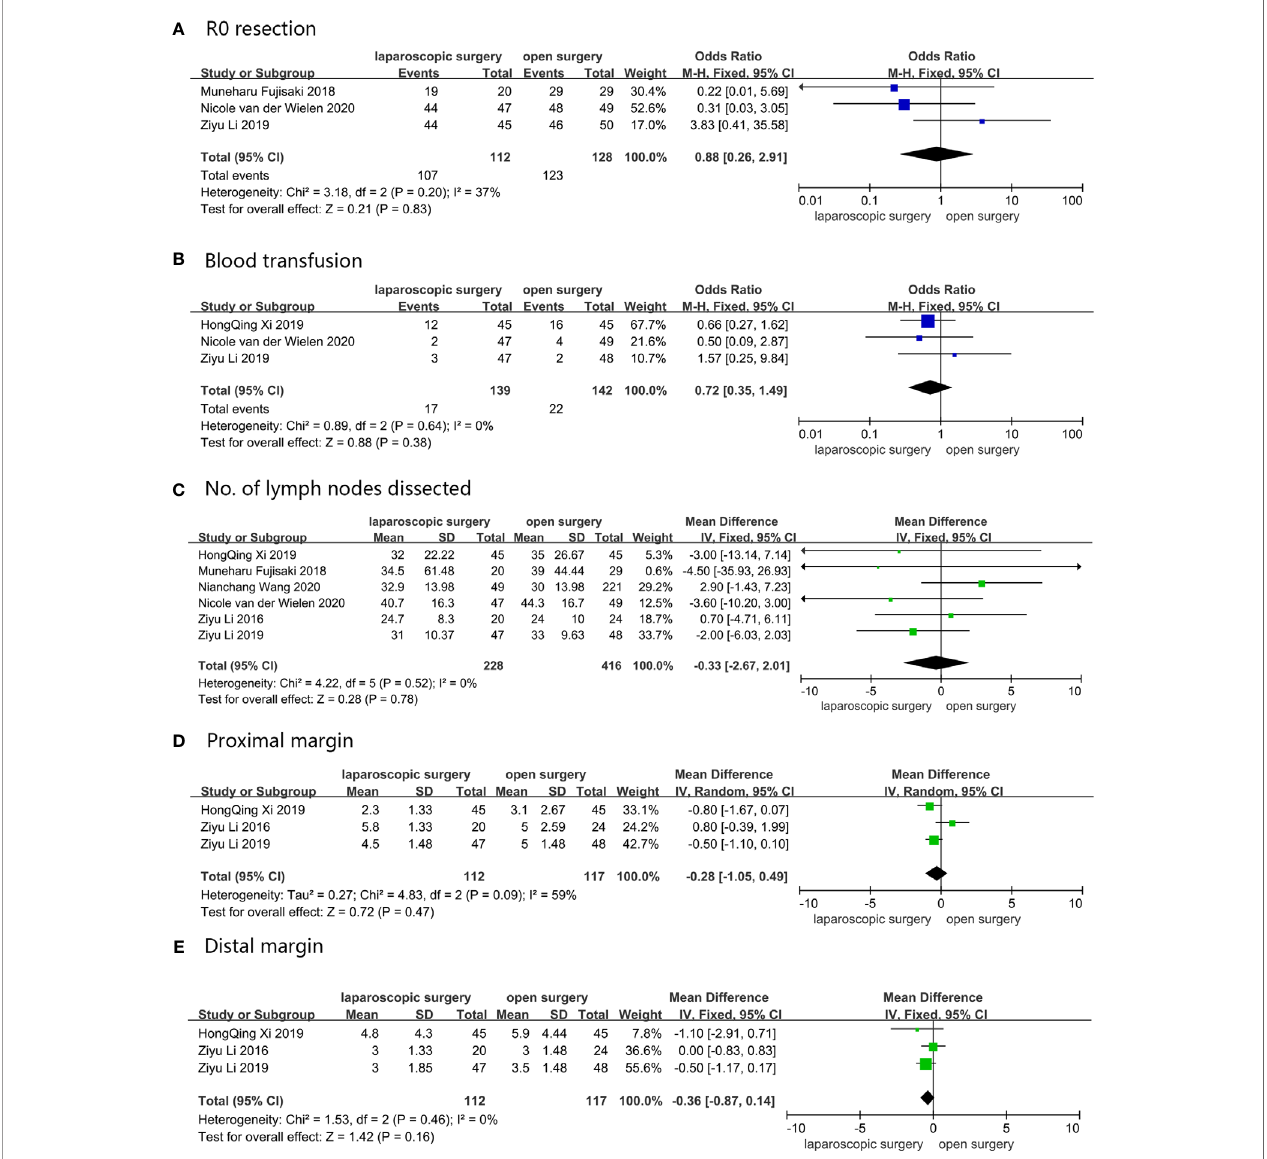
FIGURE 2 | Intraoperative conditions: (A) R0 resection; (B) Blood transfusion; (C) No. of lymph nodes dissected; (D) Proximal margin; (E) Distal